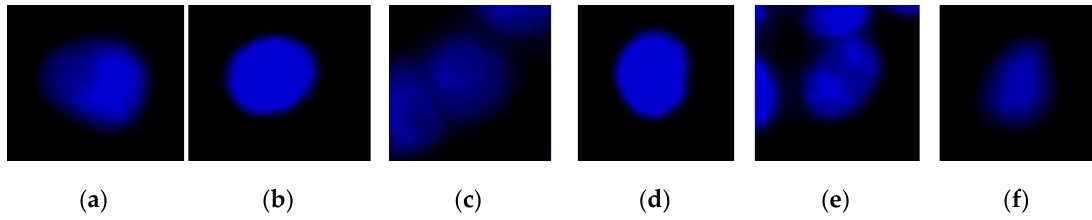
Figure 1. Images of the normal cell nucleus: ( a ) type 1; ( b ) type 2; ( c ) type 3; ( d ) type 4; ( e ) type 5; ( f ) type 6.